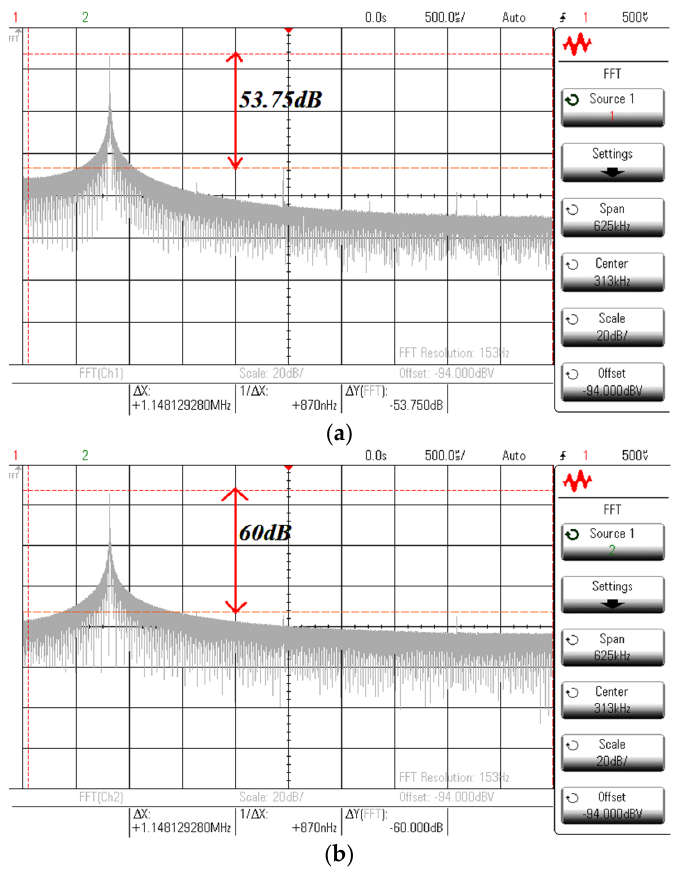
Figure 26. Measured output spectrum of v o 1 and v o 2 . ( a ) v o 1 . ( b ) v o 2 .